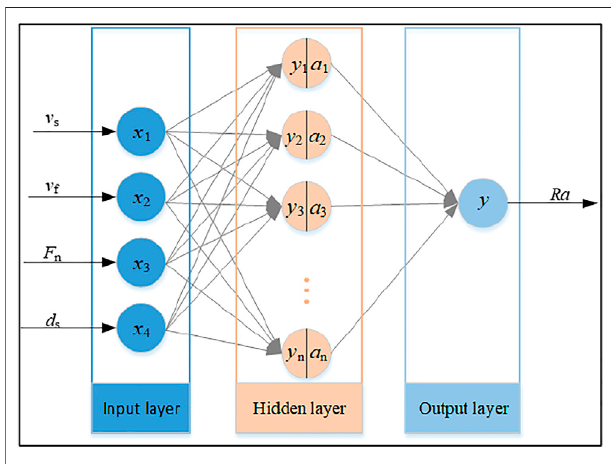
FIGURE 2 | Propagation process diagram of the neural